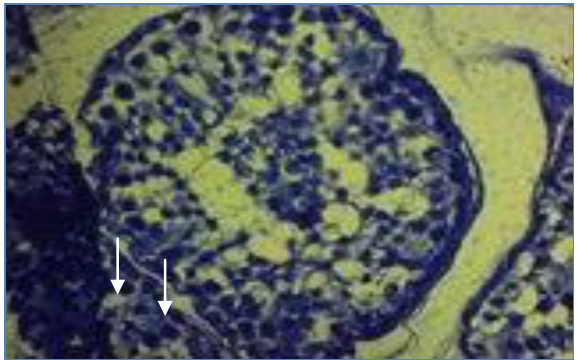
Figure, 4: Acidophilic nucleus cytoplasm (arrows) of Leydig cell during summer season. PAS